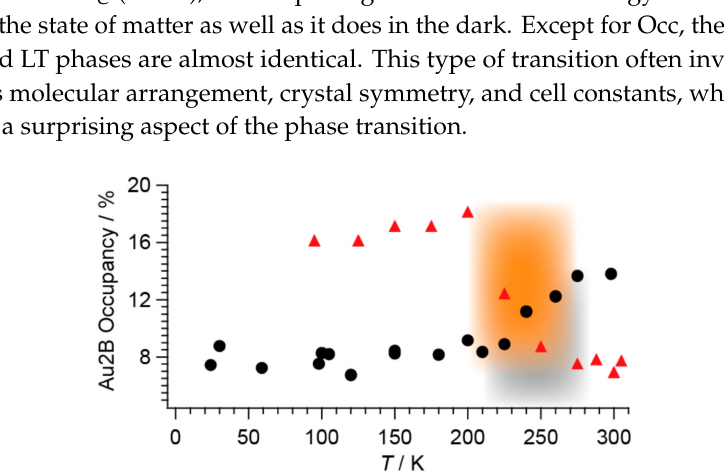
(HT) q = 0.01 (LT) and